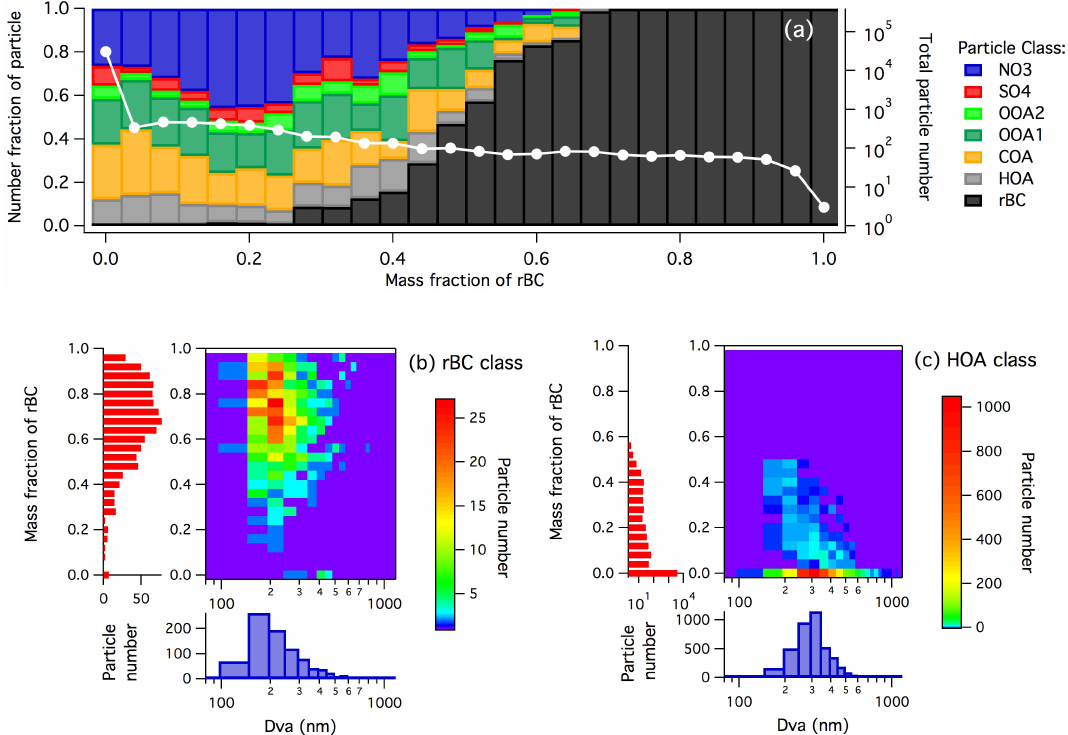
Figure 10. (a) Histogram (normalized to the total number of particles in each bin) of the mass fraction of rBC for all particle classes (left axis). The while circle markers represent the total number of particles (right axis) in each bin. Distributions of particle size and black carbon mass fraction for (b) rBC-rich class and (c) HOA-rich